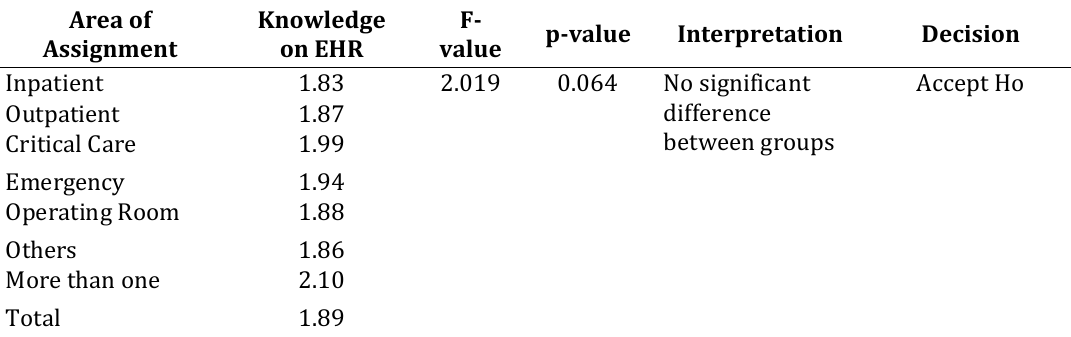
Differences in the responses of participants related to the attitude of nurses when grouped according to area of assignment Area